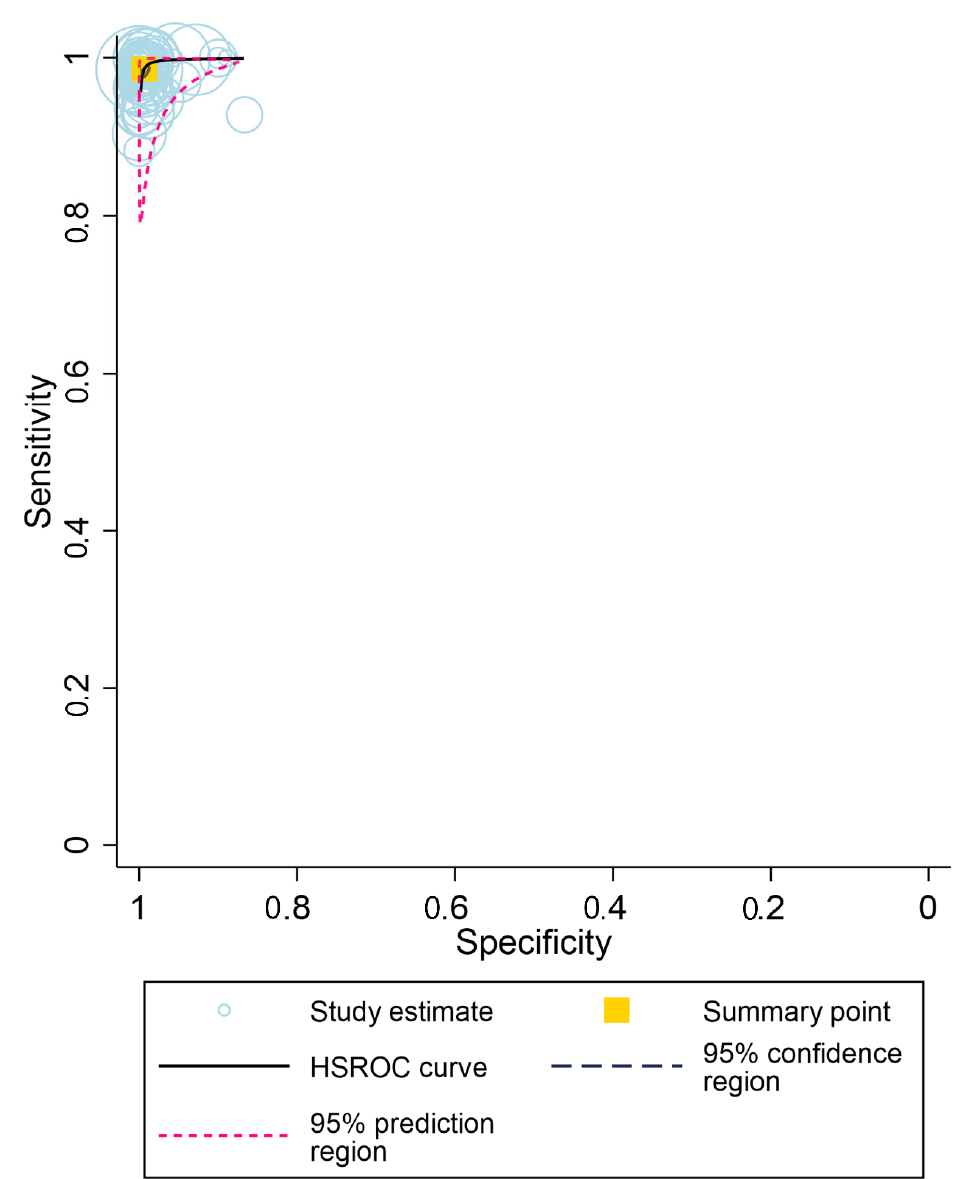
Figure 5. Hierarchical summary receiver-operator curve for the diagnostic accuracy of point-of-care HCV RNA assays used to diagnose chronic HCV infection. (Overall, with all studies combined).